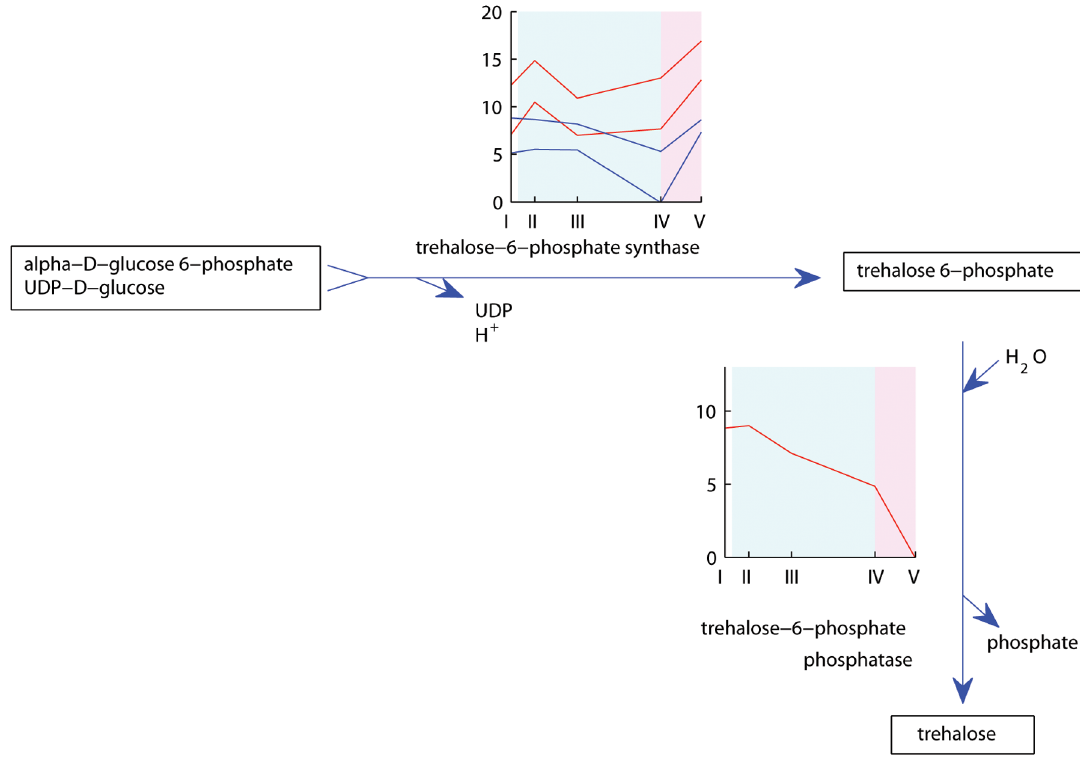
Figure 9. Expression profiles of Falster and Veyo transcripts involved in trehalose-6-phosphate synthesis and degradation. Falster transcripts are depicted in blue, Veyo transcripts in red. The x axis presents the sample collection time points: I= autumn conditions, before the start of vernalization; II=2 days of vernalization; III=4 weeks of vernalization; IV=9 weeks of vernalization; V=7 days of long day conditions. The y axis corresponds to the variance stabilized data from DESeq. The blue background illustrates vernalization treatment, the pink background illustrates long day conditions. Figure adapted from the Plant Metabolic Pathways database (http://www.plantcyc.org/).